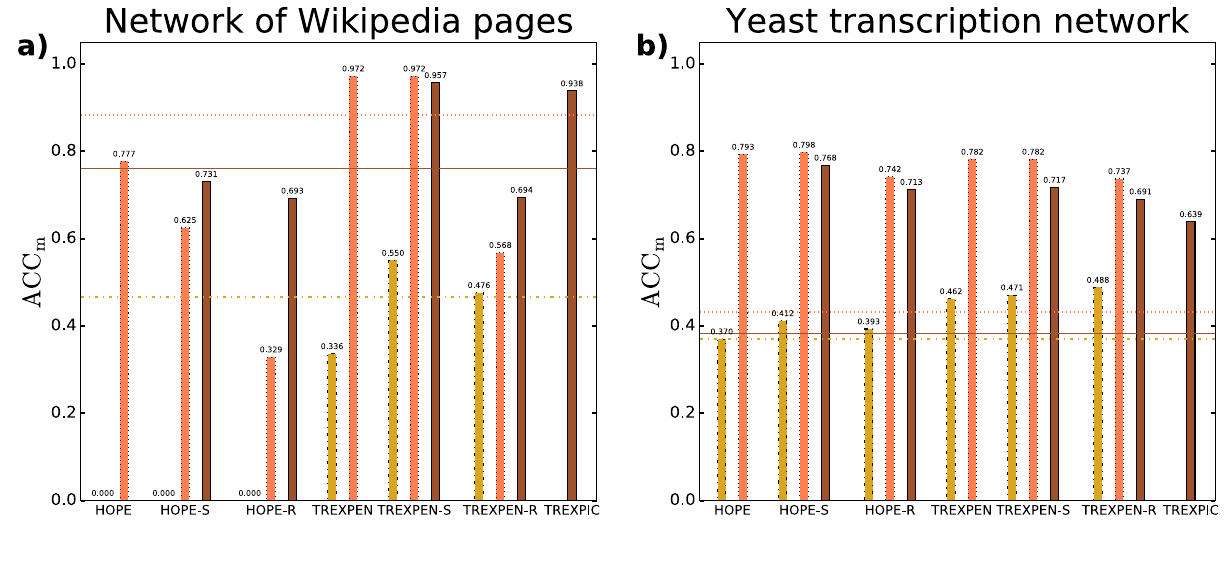
even struggle to surpass the performance of the local methods.